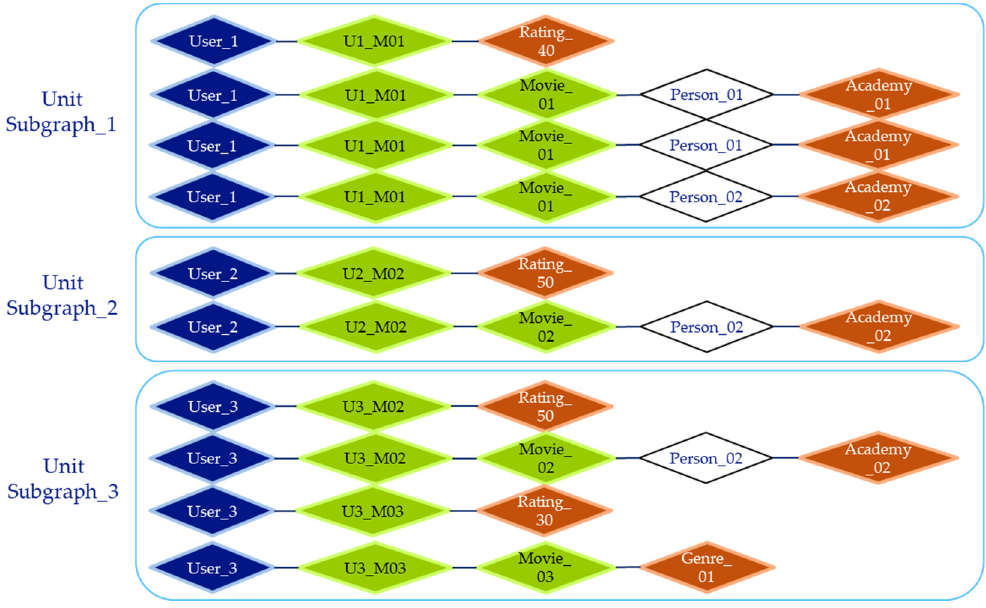
Figure 8. Instance triple paths by user in start class.